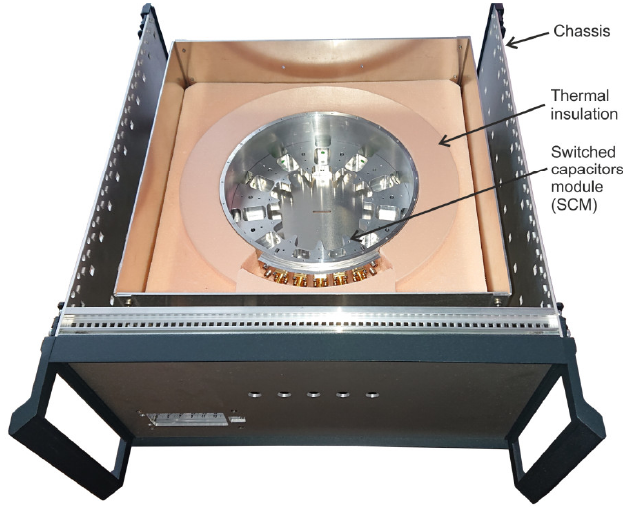
Figure 8. A photograph of the SCM showing the thermal insulation and the aluminum chassis.